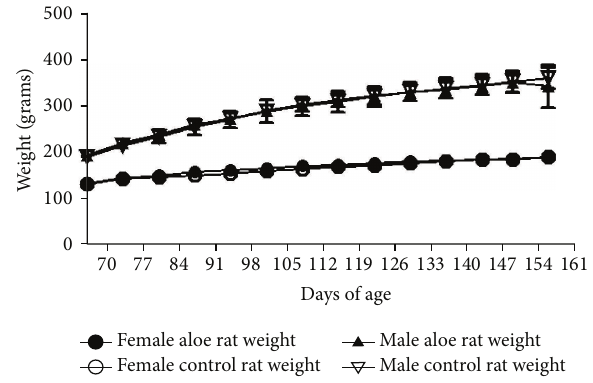
Figure 3: Weekly feed consumption of male and female rats fed DCWL aloe vera diet over 13 weeks. The symbols represent mean values for control and aloe-fed groups error bars show standard